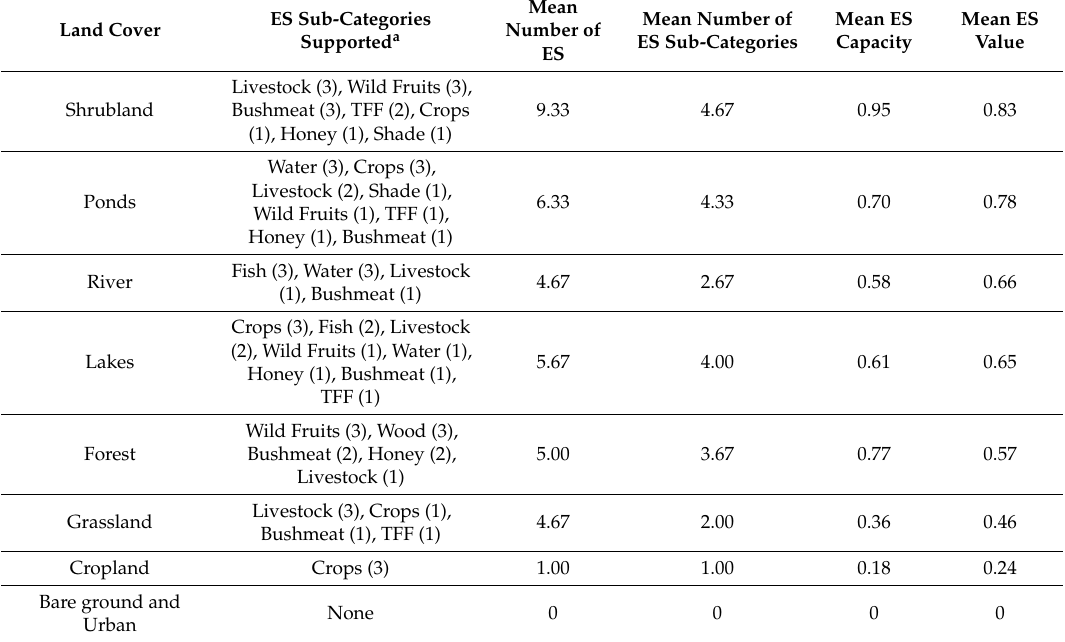
a Brackets represent the number of communities that reported services in each ES